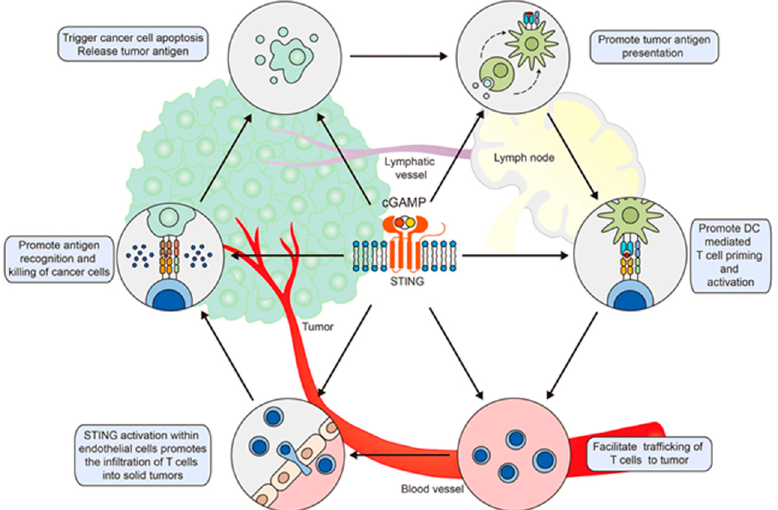
Figure 5. Activation of STING positively regulates each step of the cancer immunity cycle. Reproduced from Figure 2 of [84] with permission under the terms of the Creative Commons Attribution 4.0 International Licence (http://creativecommons.org/licenses/by/4.0/, accessed on 5 August 2021).